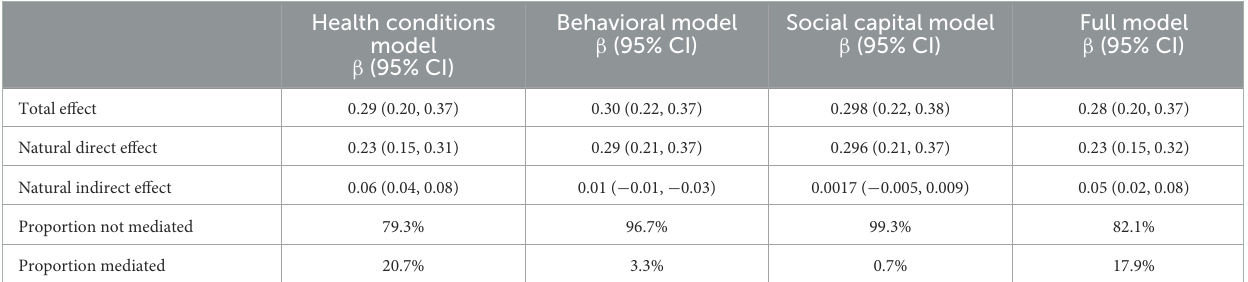
TABLE 3 Total, natural direct and natural indirect effects of socioeconomic position on cognitive function, with mediation through health conditions, behavioral and social capital